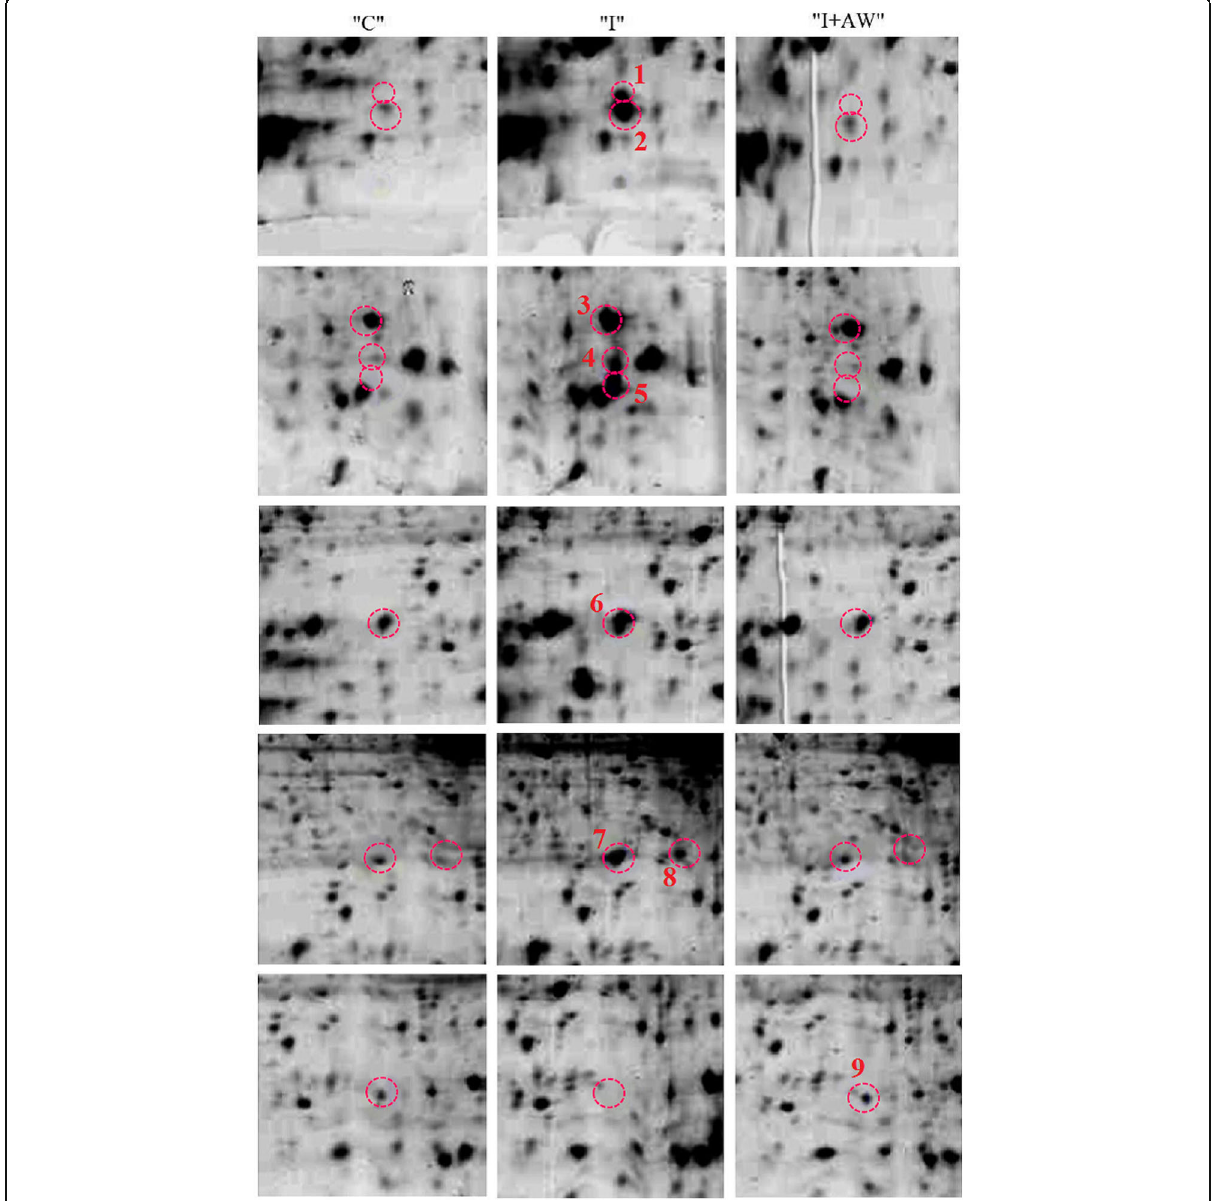
Fig. 5 Enlarged differentially expressed spot images from the respective gels. The proteins (No. 1 – 9) are as follows: 1. Lgals7, 2. Fabp5, 3. Myl9, 4, 5. Csta, 6. Tagln, 7, 8. Hspb1, 9. Alb. ( “ C ” : control group, “ I ” : rats with indomethacin-induced gastric ulcer, “ I+AW ” : ulcerated rats treated with AW